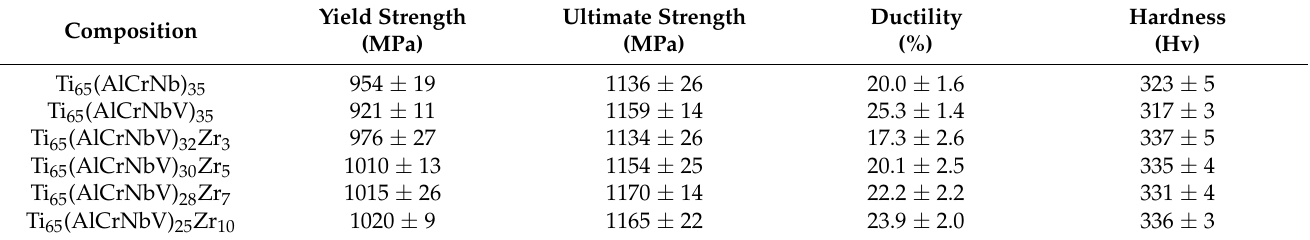
Figure 2. The appearance of the as-cast Ti 65 (AlCrNbV) 35-x Zr x (x = 3, 5, 7, 10) MEAs. ( a ) Zr3-100x; ( b ) Zr5-100x; ( c ) Zr7-100x; and ( d ) Zr10-100x. ( b ) Zr5-100x; ( c ) Zr7-100x; and ( d ) Zr10-100x. Table 3. Tensile mechanical properties of as-cast Ti 65 (AlCrNb) 35 , Ti 65 (AlCrNbV) 35 , and Ti 65 (AlCrNbV) 35-x Zr x (x = 3, 5, 7, 10) MEAs